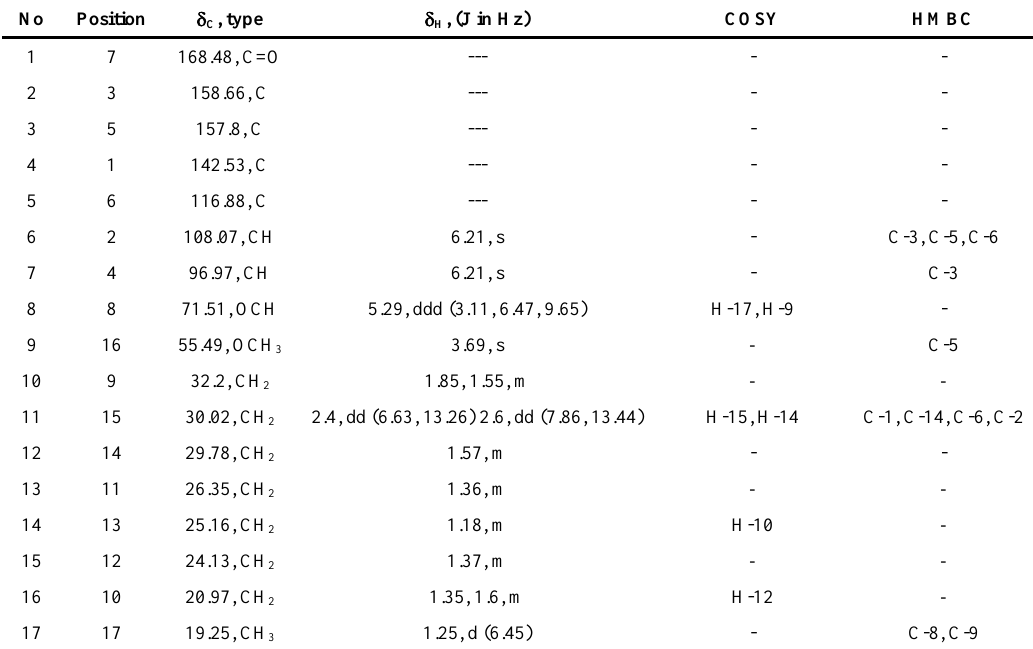
Table 9. 1 H NMR, 13 C NMR (300.13 and 75 MHz and CDCl 3 ), DEPT and HMQC Correlation of Isolated Compound